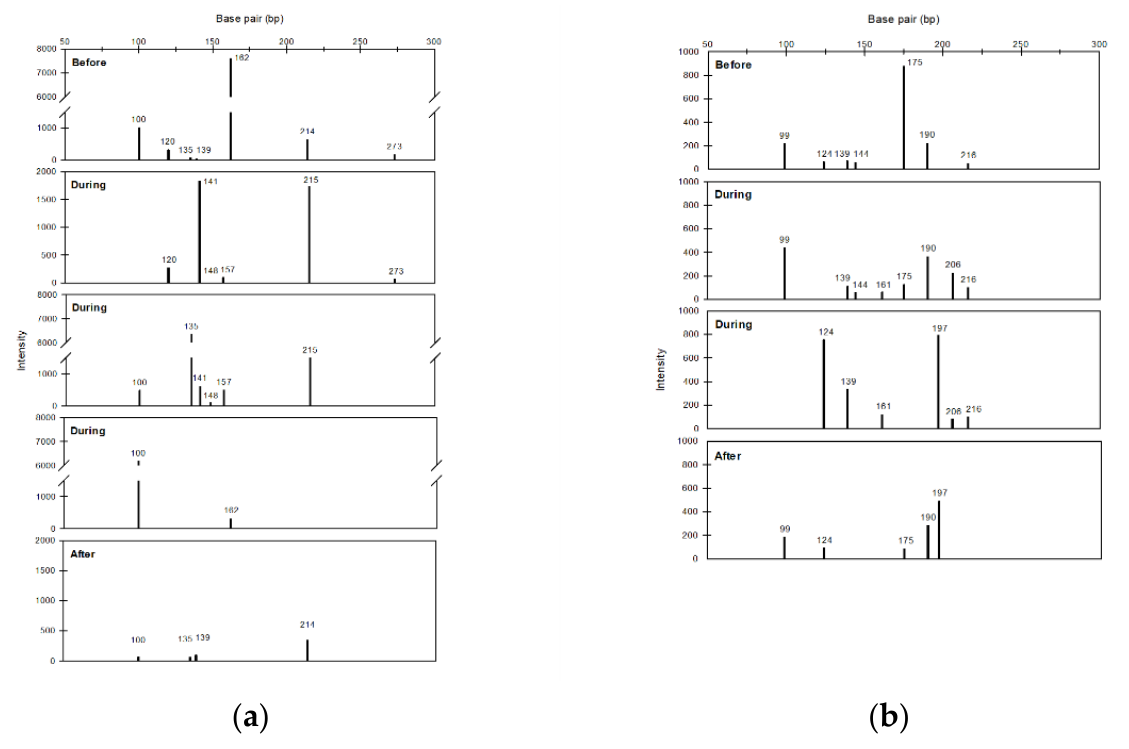
Figure 8. Histograms of particular terminal restructure fragments of bacteria in samples of NTU before, during and after frontal pollution cases (FP2 ( a ) and FP6 ( b )).